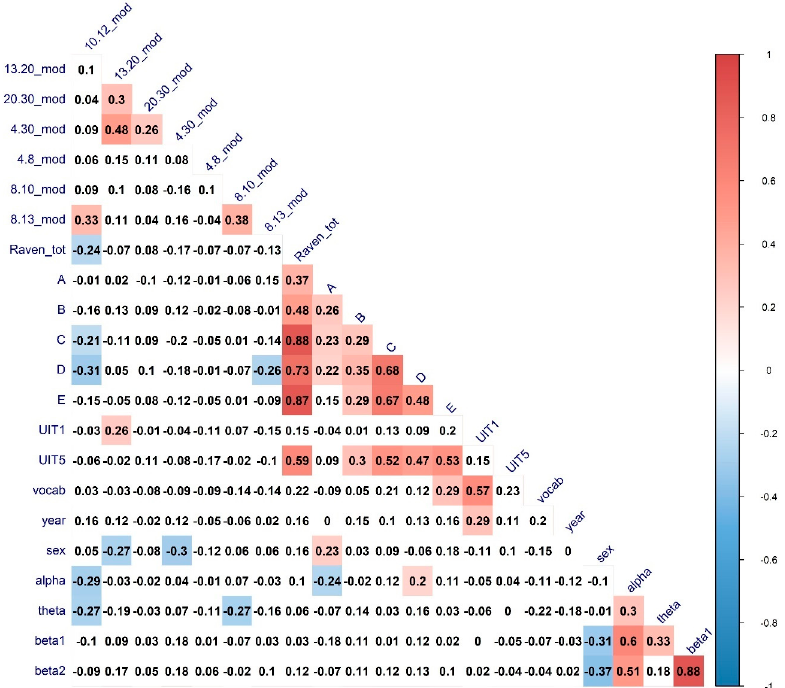
Figure 2. The heatmaps of the correlations between cognitive abilities measures, modularity, sex, age, and EEG Frequency bands power. Correlations of significance level p < 0.05 are marked in color. Mod—Modularity; UIT1—”Awareness” verbal subtest, UIT5—”Conclusion” subtest of the Universal Intellectual Test, vocab—“MyVocab” test. The results are adjusted for multiple comparisons with the FDR method.